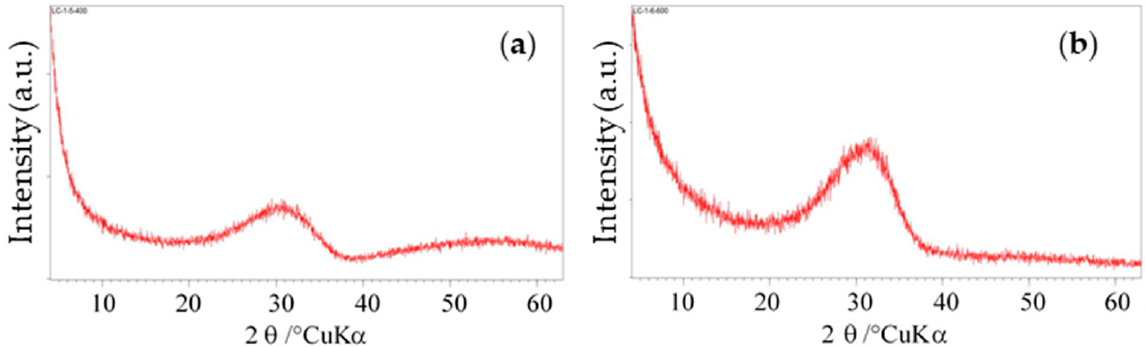
Figure 4. X-ray diffractograms of powdered sol–gel TiO 2 –ZrO 2 samples: ( a ) annealed at 400 °C; ( b ) annealed at 600 °C.